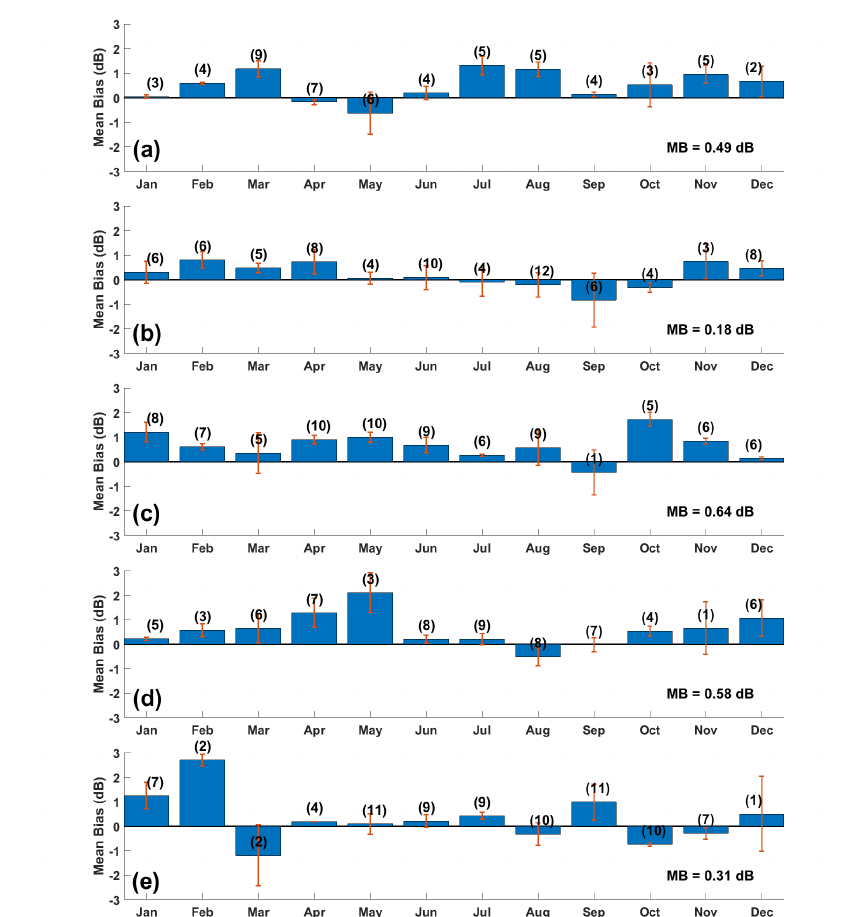
Figure 6. Bar diagram of monthly DPR-GR mean reflectivity bias with standard deviation for the years 2014 to 2018. Numbers in round brackets signify total number of overpasses for that month from April 2014 to June 2018. ( a ) KFWS radar; ( b ) KHGX radar; ( c ) KSHV radar; ( d ) KLIX radar; ( e ) KMLB